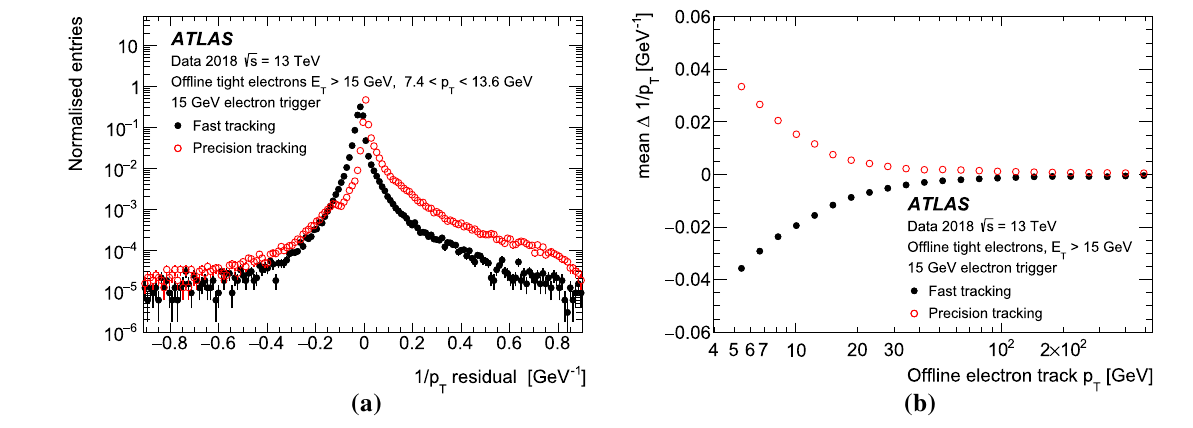
the 15GeV tag and probe trigger ( a ); and the mean of the residual as a function of the offline track p T ( b ) for the fast and precision